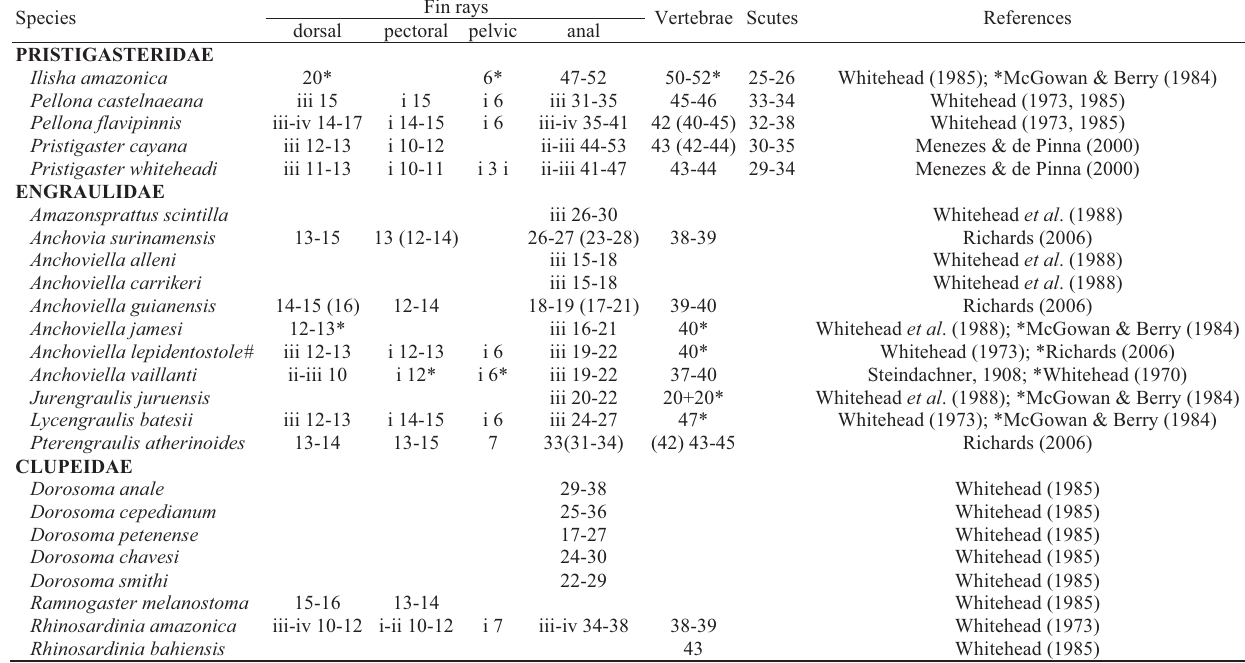
Table 1. Meristic data of exclusively freshwater neotropical clupeiform species (#euryhaline marine